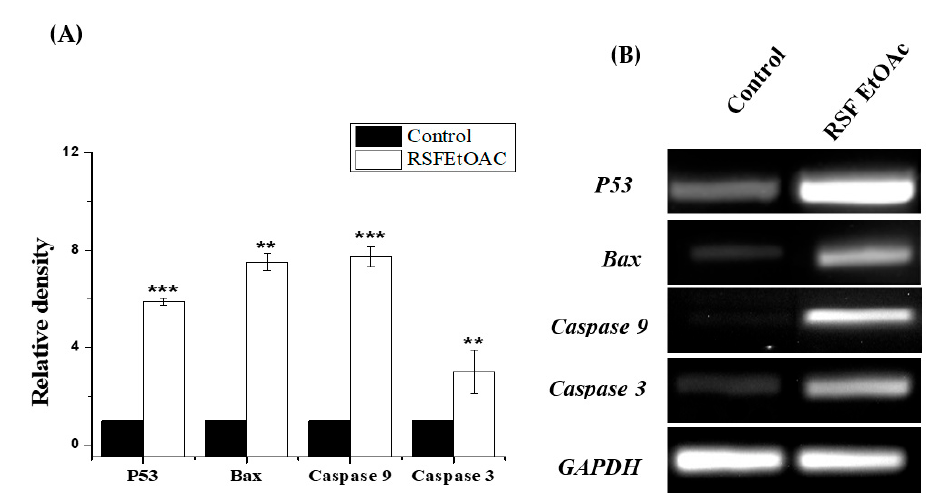
Figure 3. E ff ect of RSF EtOAc extract on P53 , Bax , caspase-9 and caspase-3 mRNA levels in MDA-MB-231 Figure 3. Effect of RSF EtOAc extract on P53, Bax, caspase-9 and caspase-3 mRNA levels in MDA-MB-